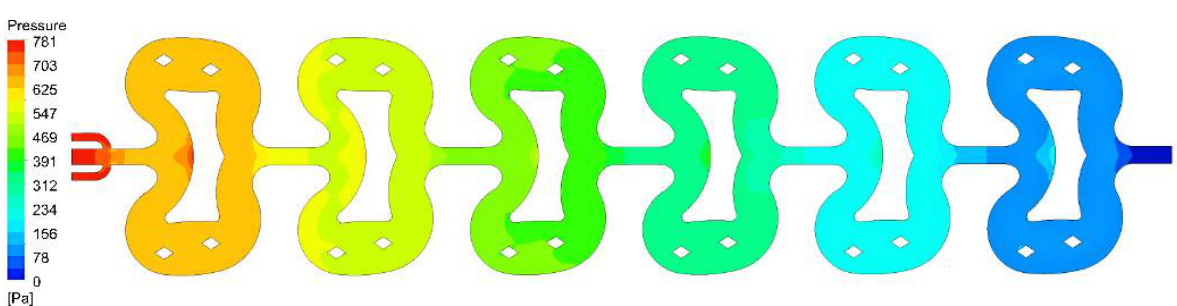
Figure 4. The pressure field in the butterfly-shaped microreactor at a total flow rate of 20 mL/min.